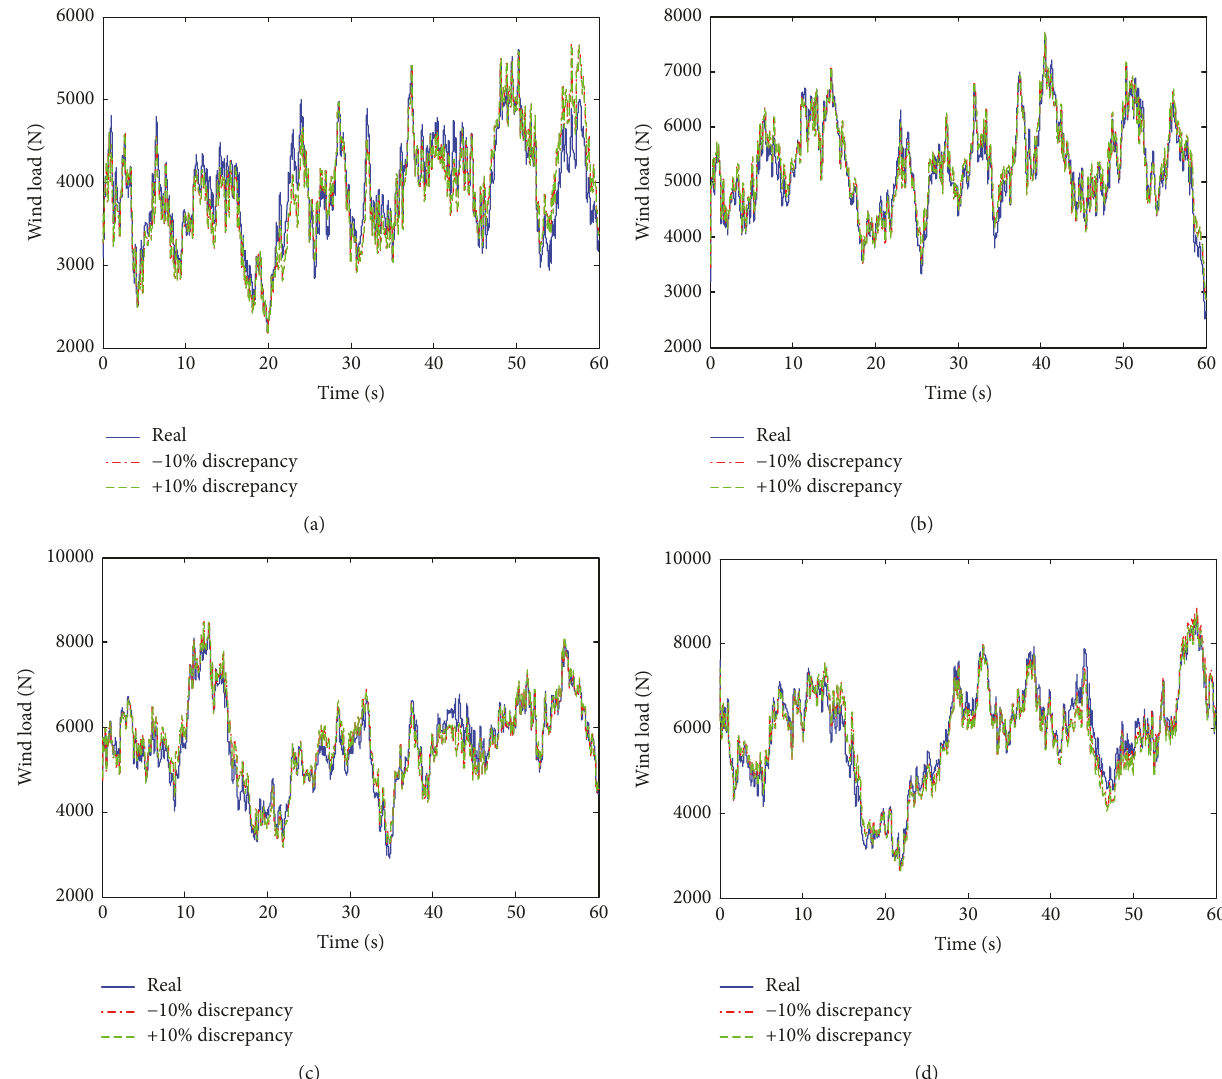
Figure 9: The histories of the estimated wind load with ± 10% discrepancy in damping ratio error. (a) On the 5th floor; (b) on the 10th floor; (c) on the 15th floor; (d) on the 20th